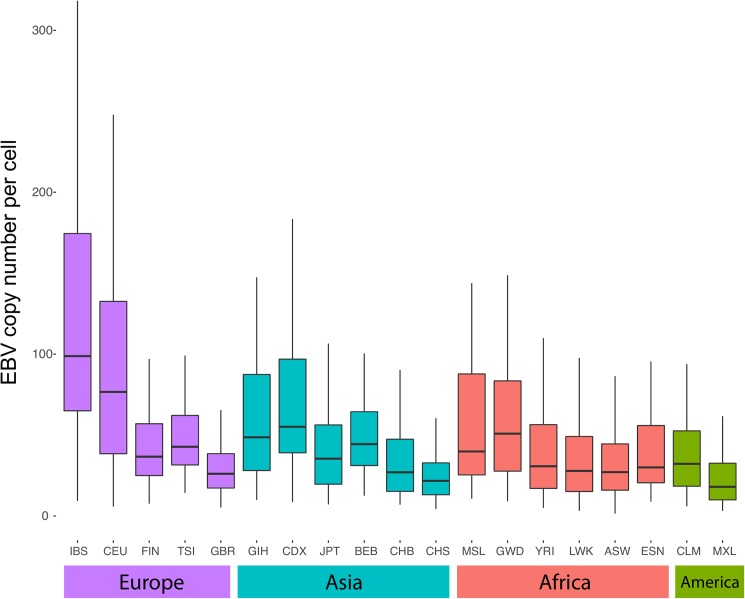
Distribution of EBV copy number across LCL samples.Boxplot showing the distribution of EBV copy number in LCLs across 1000 Genome Project populations. (Population acronyms are explained in Table 1).